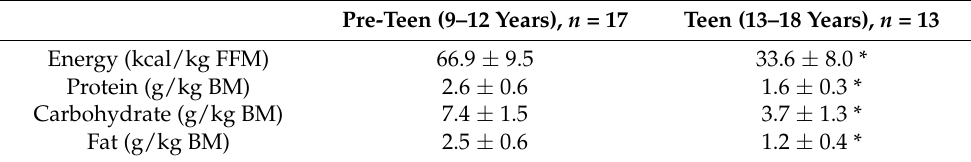
Table 3. Energy, macronutrient intakes per body weight in pre-teen and teen gymnast groups.